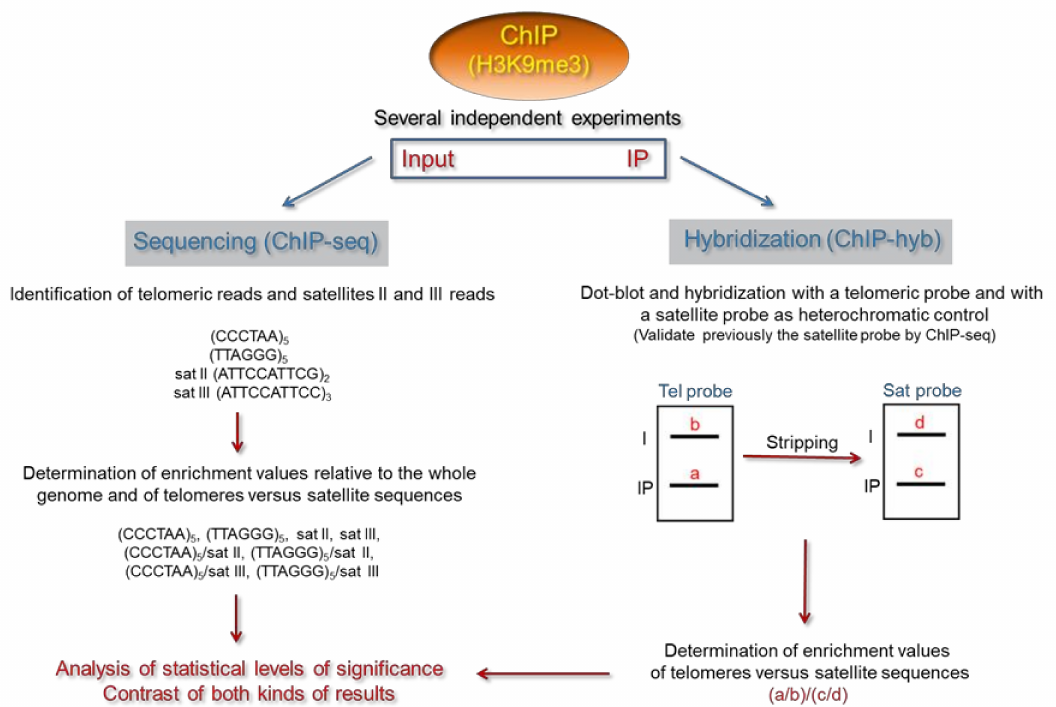
Figure 1. Schematic representation of the experimental pipeline proposed to assess the heterochromatic status of human telomeres by ChIP. ChIP experiments should be performed using antibodies against H3K9me3. At least three independent biological replicates are recommended, thus statistical analyses of enrichments can be performed. Since the consensus sequences of satellites II and III are [(atTCCATTcg) 2 + (atg) 1–2 ] n and [(ATTCC) 7–13 + (ATTcgggttg) 1 ] n , respectively, the sequences indicated in the figure could be used to monitor satellites reads in the chromatin immunoprecipitation sequencing (ChIP-seq) experiments [37]. Satellite sequences could also be used as heterochromatic controls in the ChIP-hybridization (ChIP-hyb) studies once they were validated by ChIP-seq. Antibodies against alternative heterochromatic marks such as H4K20me3 or DNA methylation could be used to assess the heterochromatic status of human telomeres. However, our ChIP-seq analyses reveal low (but significant) levels of H4K20me3 enrichment at satellites II and III (our unpublished results), which seems to be in agreement with previously reported analyses of mouse pericentromeric heterochromatin